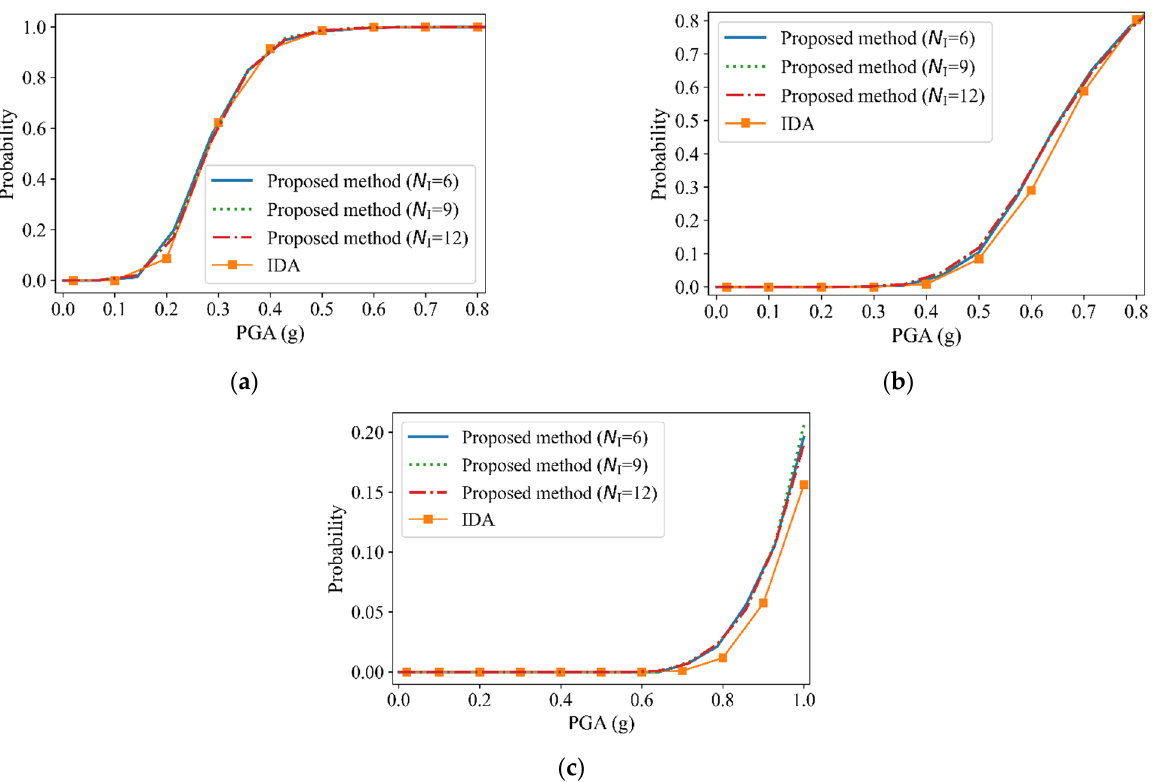
Figure 11. Fragility curves of MFVCS obtained using different approaches. ( a ) Immediate occupancy. ( b ) Life safety. ( c ) Collapse prevention.